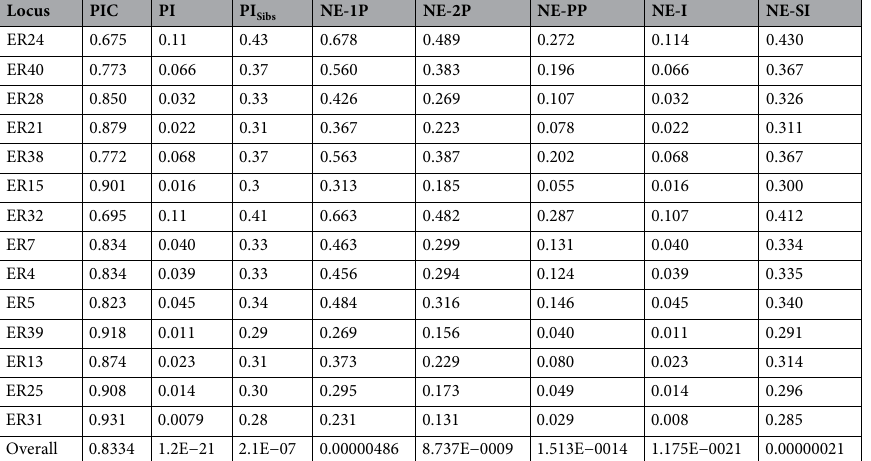
Table 2. Informativeness and exclusion probability of analyzed loci, estimated based on genotypes of 69 unrelated individuals of European Robin from Poland and Portugal. PIC—polymorphic information content, PI—probability of identity; PI Sibs —probability of identity for sibs; paternity non-exclusion probability (first second and pair parent, NE-1P, NE-2P and NE-PP respectively) and the combined non-exclusion probability of identity and sibling identity (NE-I and NE-SI) for each marker; overall—values for combination of 14